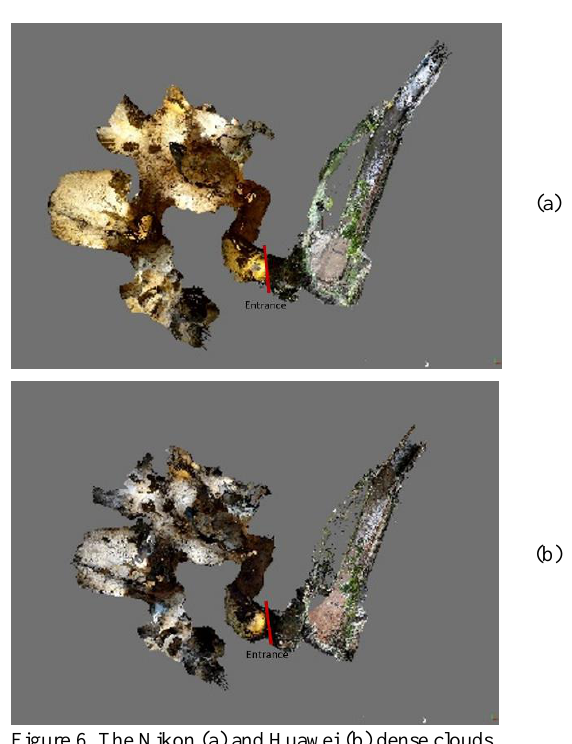
Figure 6. The Nikon (a) and Huawei (b) dense clouds